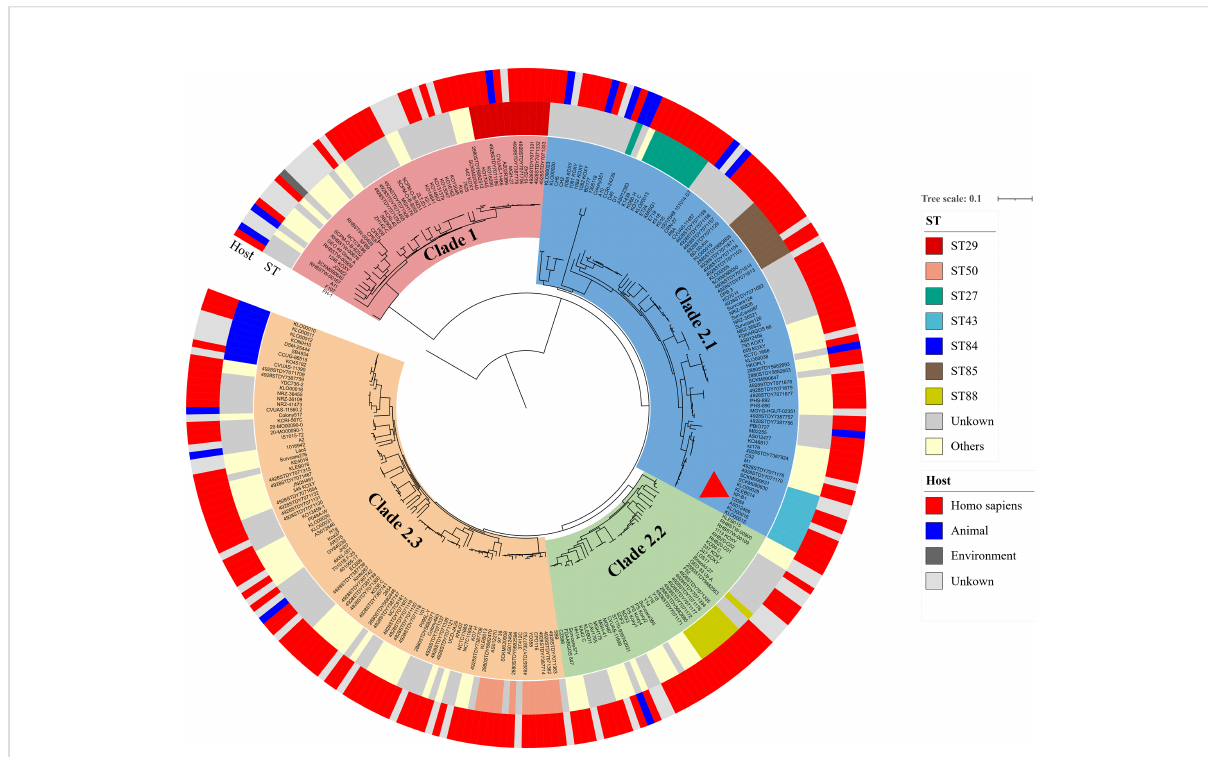
FIGURE 4 A maximum-likelihood clustering tree of the 275 available K. michiganensis strains. The maximum-likelihood clustering tree is constructed by 503,605 SNPs of all 275 K . michiganensis genome sequences. K. variicola FH-1 (GenBank accession no. CP054254) is used as the outgroup; The outermost circle presents the sources of the isolates; the sub-outside circle presents the STs of the isolates; the innermost circle presents different Clades of K. michiganensis ; the strain 12084 is marked with a red